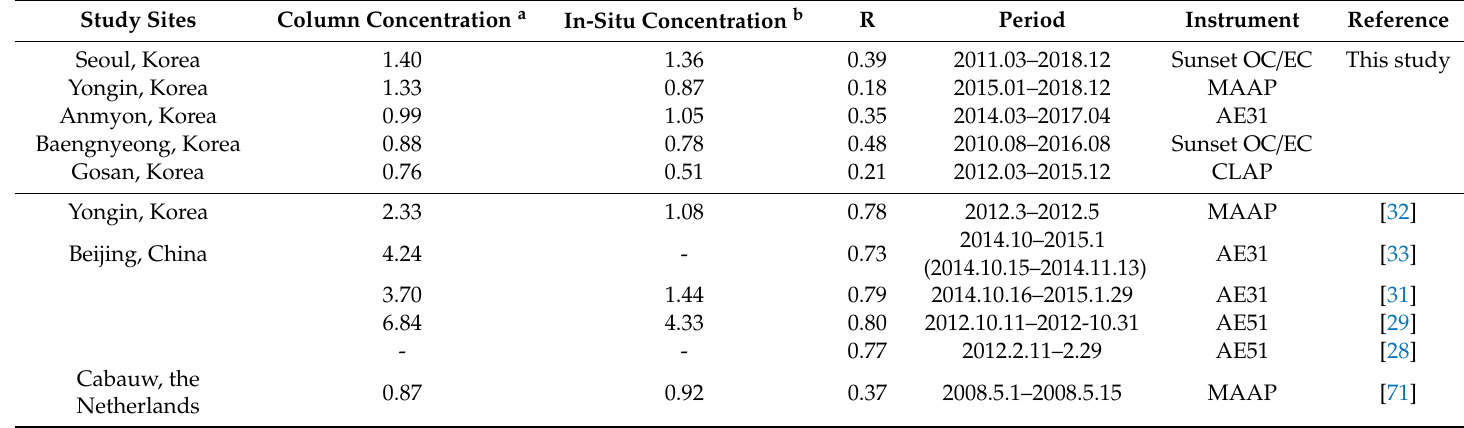
Table 3. Summary of comparison results between the column and the in-situ black carbon (BC) concentrations using linear regression ( y = ax + b ). Study